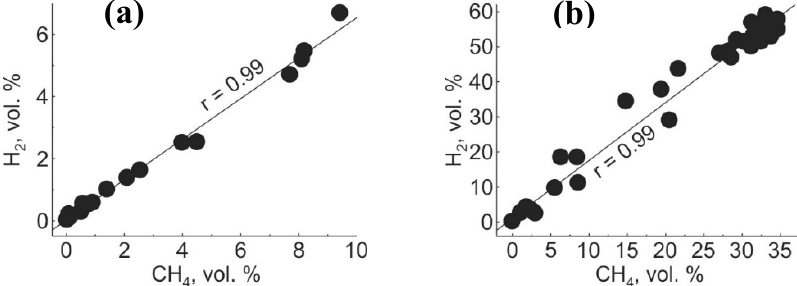
Figure 11. Ratios of FG-dominating components in exploration borehole #1253, the Kukisvumchorr apatite-nepheline deposit ( a ), and in shot-hole #173, the Karnasurt Mine, the Lovozero loparite deposit ( b ).